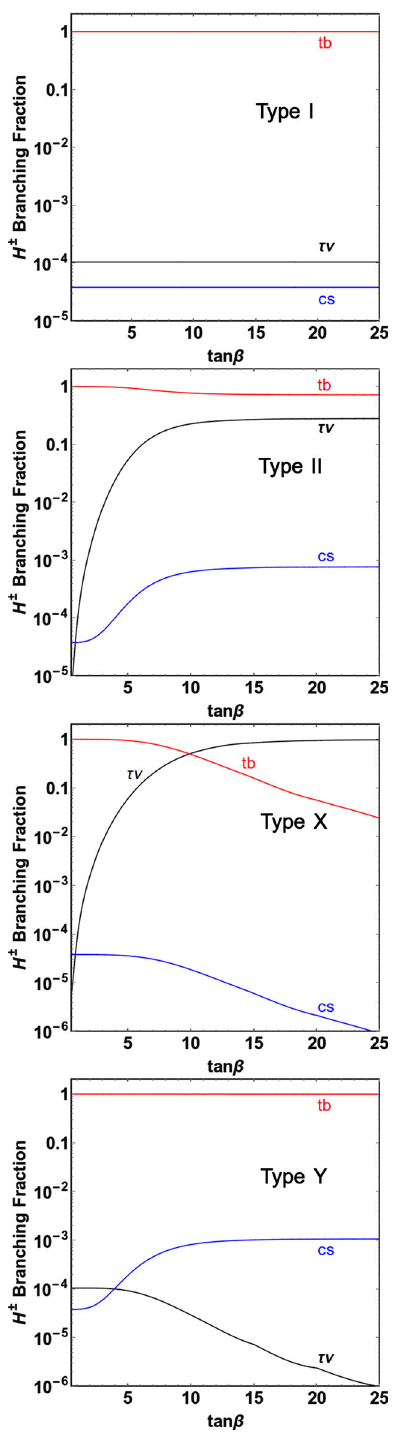
Fig. 2 Branching fractions of the charged Higgs particle into the dom- inant fermionic sectors as a function of tan β for M H ± = 250 GeV. The alignment limit sin (β − α) → 1 and degenerate M H ± , M H and M A are considered to prevent H ± → W ± φ ( φ = h , H , A ) and satisfy the T parameter